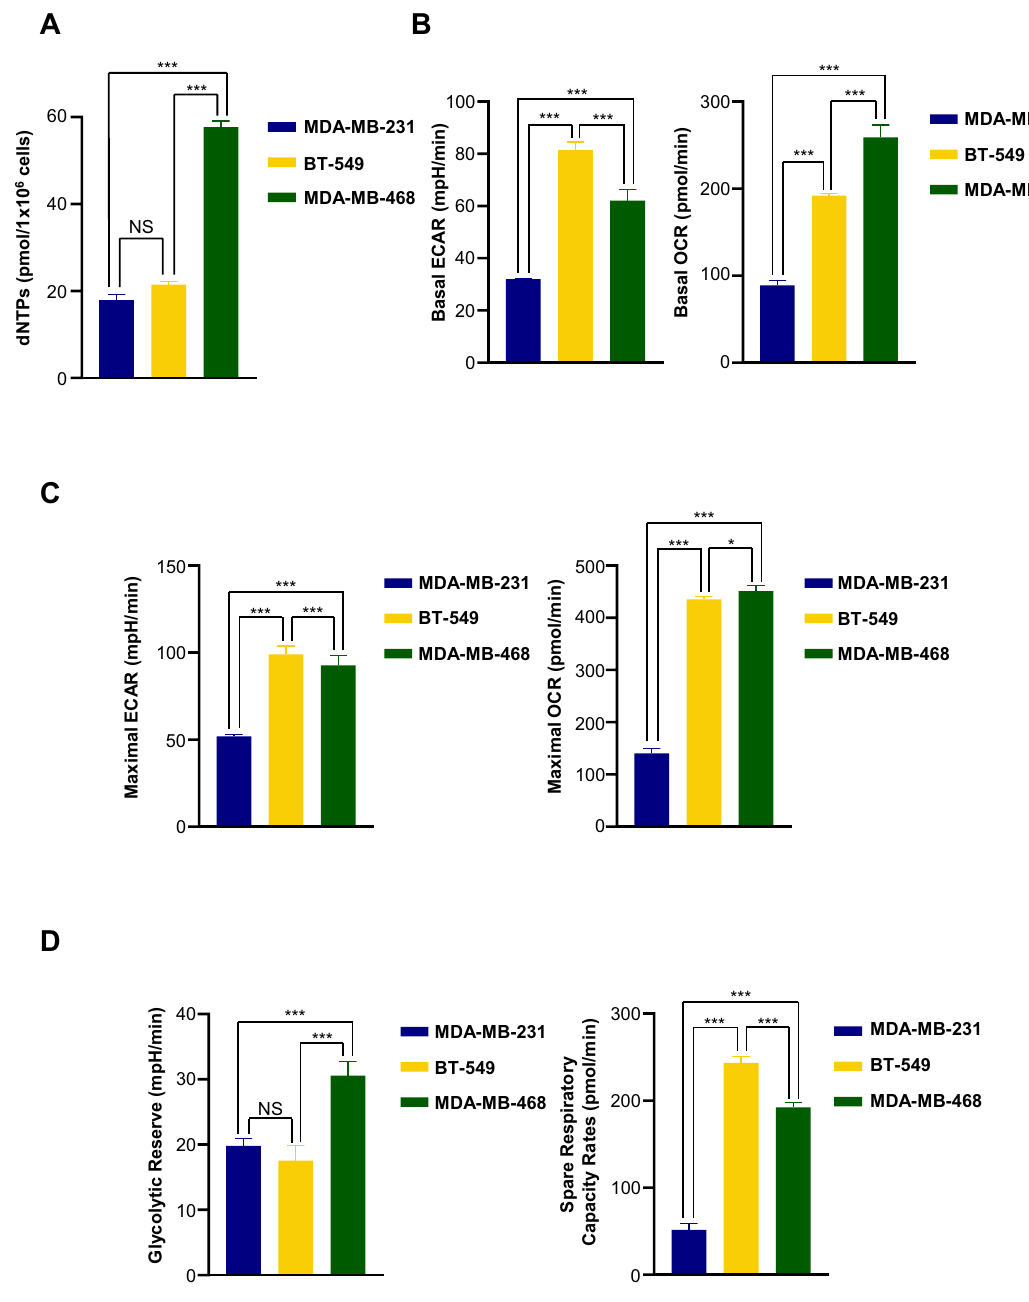
Figure 7. Effects of CT on energy metabolism according to TNBC cell subtypes. ( A ) Quantification of total dNTP levels of three TNBC cell lines with different genetic backgrounds. Considering Lehmann classification, three representative cell lines of TNBC subtypes were determined as BT-549 (mesenchymal stem-like (M); basal B), MDA-MB-231 (mesenchymal stem-like (MSL); basal B) and MDA-MB-468 (basal-like1 (BL1); basal A) cells. ( B ) Basal ECAR and basal OCR analysis of three TNBC cell lines. ( C ) Maximal ECAR and basal OCR analysis of three TNBC cell lines. ( D ) Glycolytic reserve and spare respiratory capacity rate of three TNBC cell lines. Metabolic profiles were measured using an extracellular flux analyzer (Seahorse Bioscience). ECAR and OCR values were normalized to a measurement of total cell numbers for each cell line in each assay. Data are averages from one representative experiment, with error bars representing SD. ( E ) Metabolic dependency of three TNBC cells tested. Original blots are presented in Supplementary Information (Figure Raw